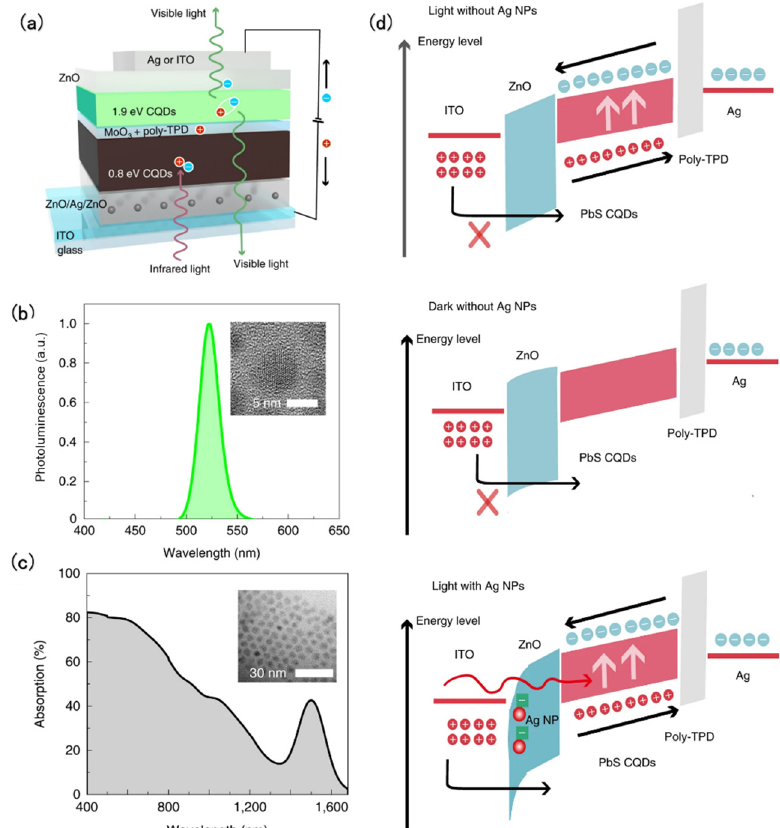
Figure 8. Structures and performance characterization of CQDs based SWIR-to-visible upconversion devices. ( a ) Structure and composition of upconversion devices. ( b ) Photoluminescence spectra of CdSe/ZnS core/shell QDs, with the peak position at 525 nm. Inset: transmission electron microscopy (TEM) of CdSe/ZnS QDs. ( c ) Absorbance of PbS QD thin films, with the exciton peak position at 1500 nm. Inset: TEM of PbS QDs. ( d ) PD energy band graph with Ag nanoparticles in ZnO film. Without Ag nanoparticles (top) or in darkness (middle), the hole transfer from the ITO film to ZnO is blocked by the energy level shift. Under the lighting (bottom), holes enter the ZnO film [61]. Copyright 2020, Nature Electronics.